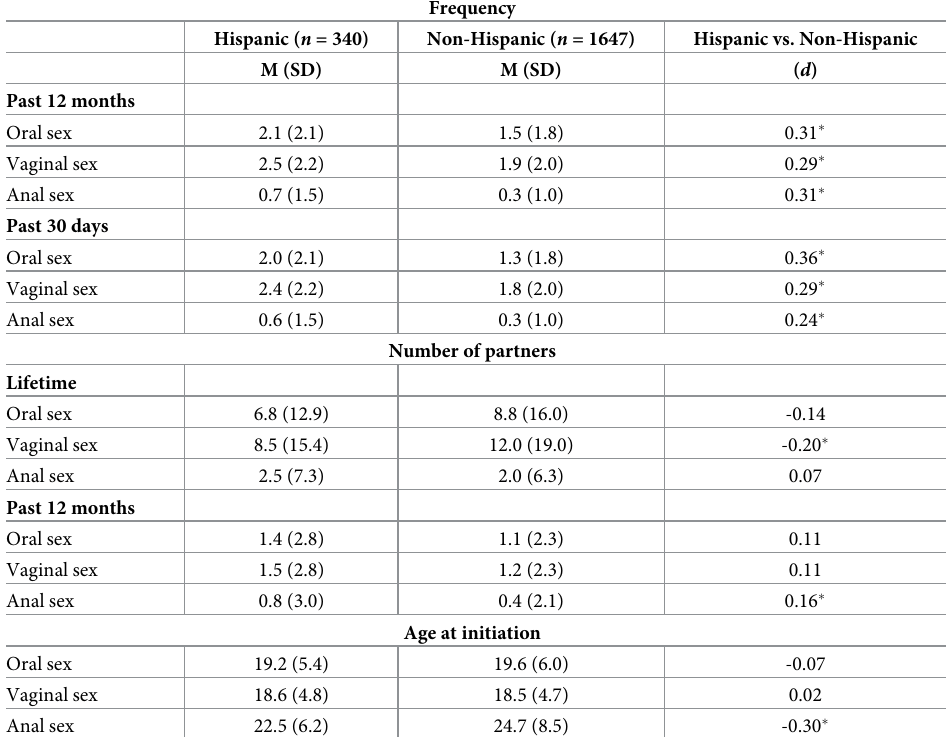
Table 9. Descriptive statistics and standardized effect sizes for group comparisons for hispanic vs. non-hispanic groups.